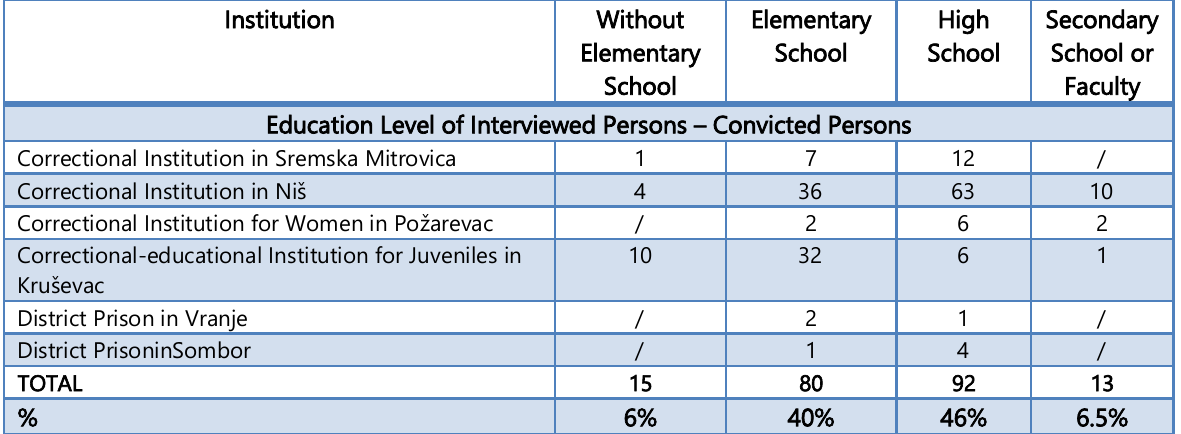
Table 6: Education Level of Interviewed Persons (Source: Author‟s depiction)